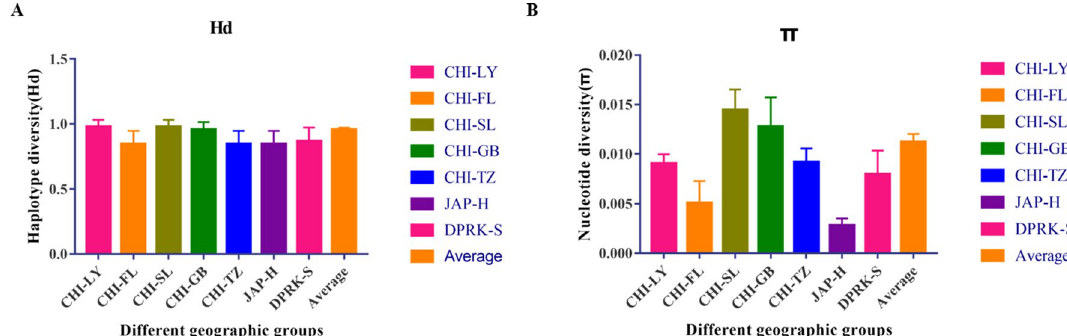
Figure 5. Bayesian skyline plots showing changes through time of NeT with uncorrected substitution rate ( R = 1). (Ne = effective population size; T = generation time with uncorrected substitution rate (R-1) based on mtDNA control region sequences of all